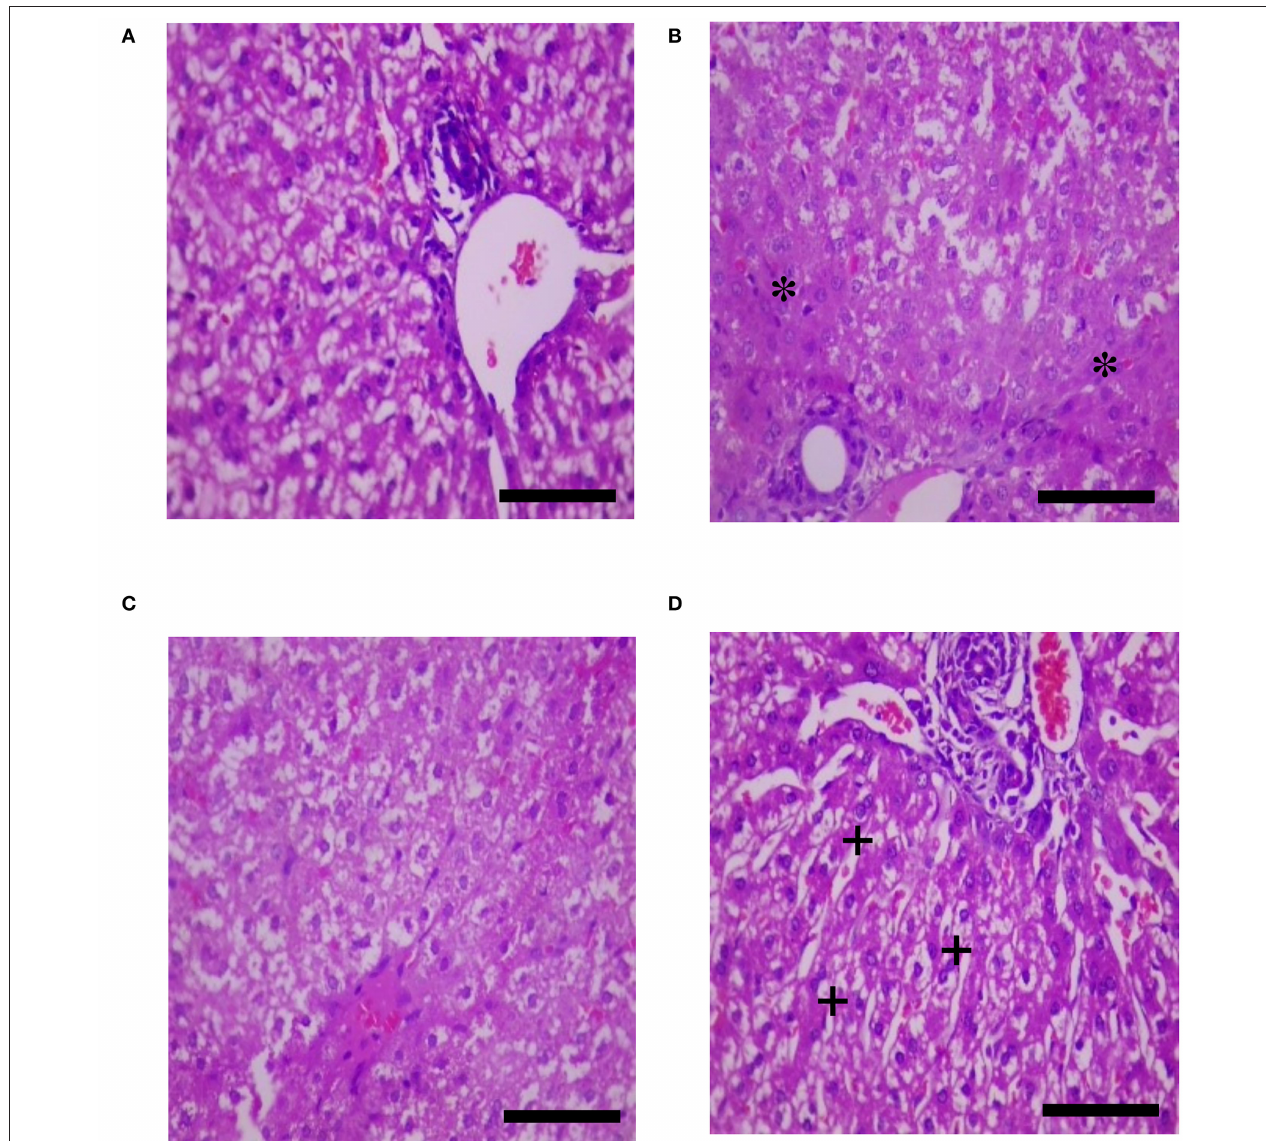
FIGURE 2 | Histological sections of livers of layers exposed to heat stress (HS) and supplemented with organic selenium-enriched yeast (SY) in the basal diet (scale bars 25 µ m). (A) Layers exposed to thermoneutral temperature at 24 ◦ C and fed a basal diet without SY supplementation; (B) Layers exposed to HS at 35 ◦ C and fed a basal diet without SY supplementation; (C) Layers exposed to HS at 35 ◦ C and fed a basal diet supplemented with 0.4 g/kg SY; (D) Layers exposed to thermoneutral temperature at 24 ◦ C and fed a basal diet supplemented with 0.4 g/kg SY. Asterisks (*) indicate the areas of hepatocytic necrosis, while plus signs ( + ) indicate the normal hepatocytic